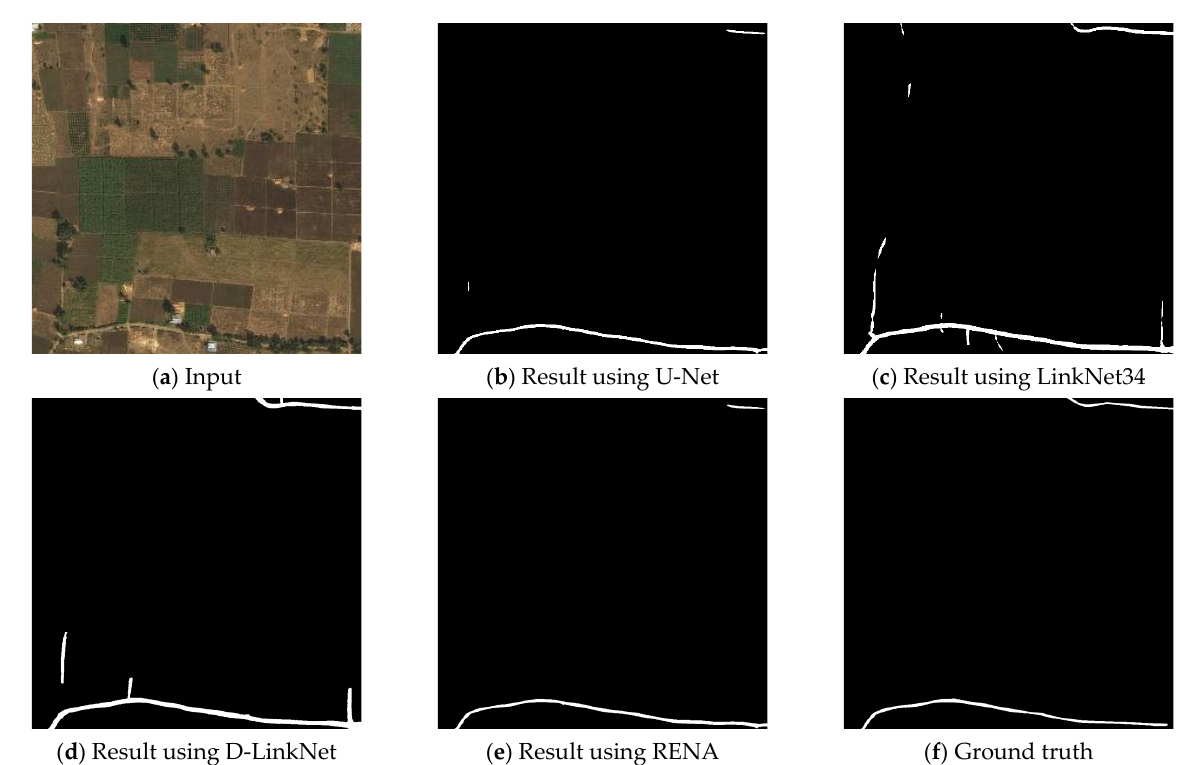
Figure 9. Visual evaluation results of the first group of sparse road networks.